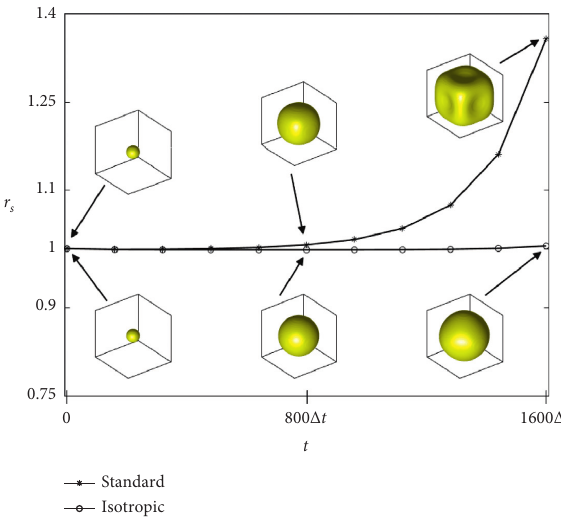
Figure 5: Plot of r s from standard and isotropic schemes.